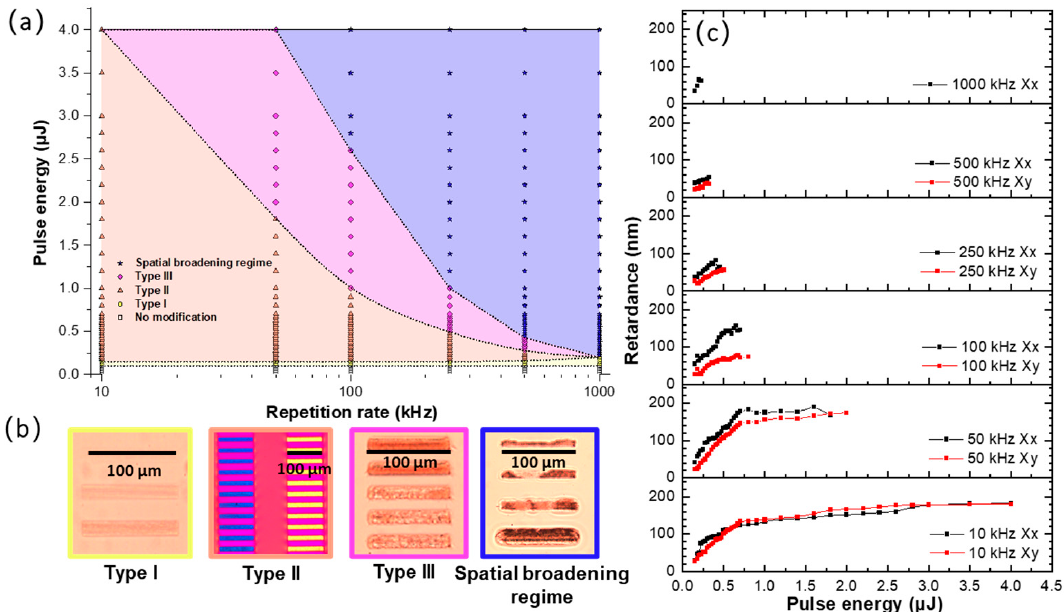
Figure 1. ( a ) Processing windows for the different types of fs-laser modifications in Borofloat33 (B33) glass. ( b ) Optical microscope images of the different types of modifications. ( c ) Retardance measured within the Type II regime by the Sénarmont technique. Experimental conditions: 1030 nm, 800 fs, 0.6 NA, from 0.025 to 4 µJ, pulse density f / v = 10 3 pulse/µm, Xx and Xy writing config- urations.